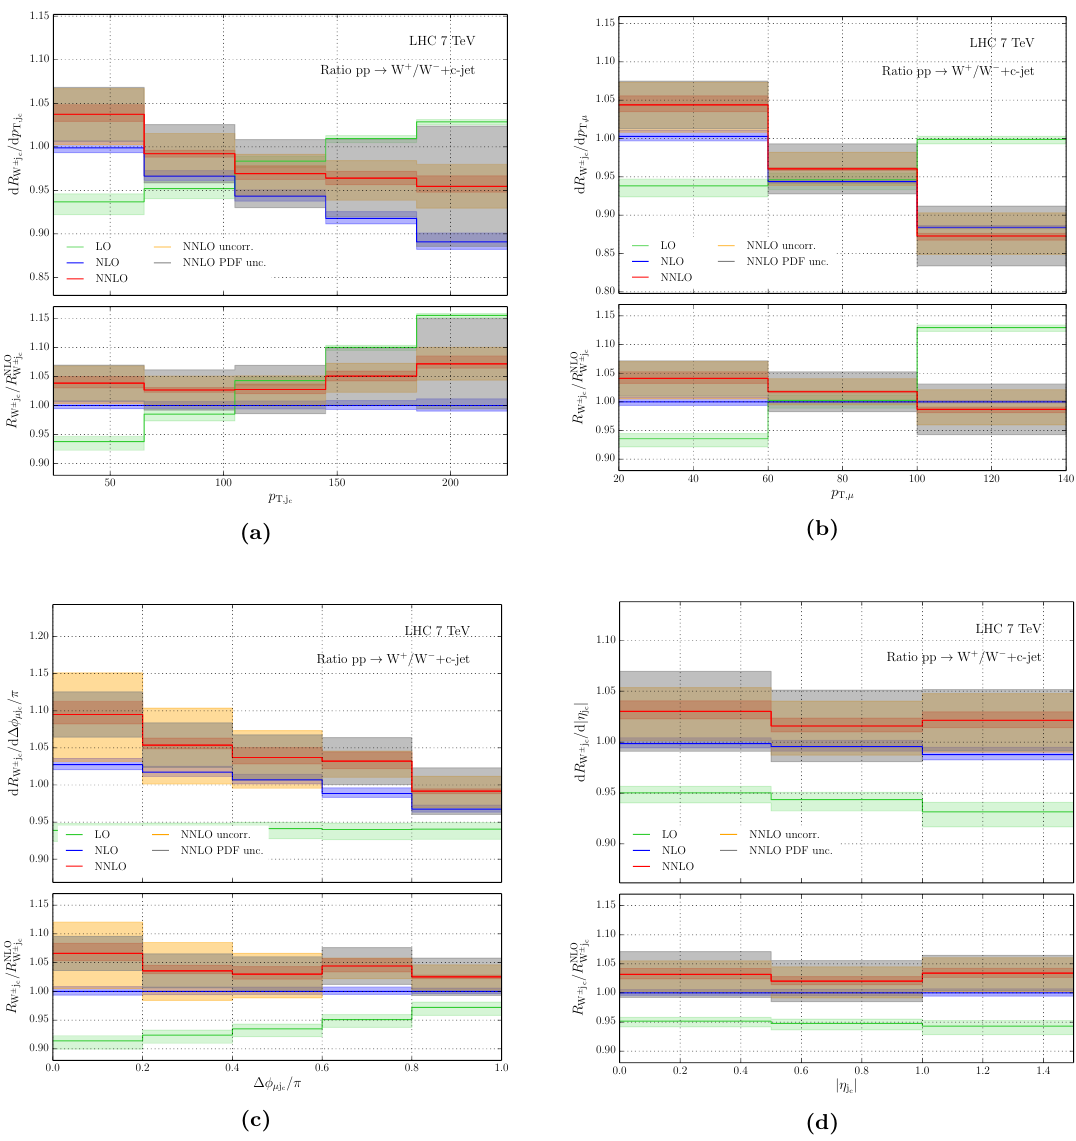
and pp → W − j at the 7 TeV c c = 0 cd